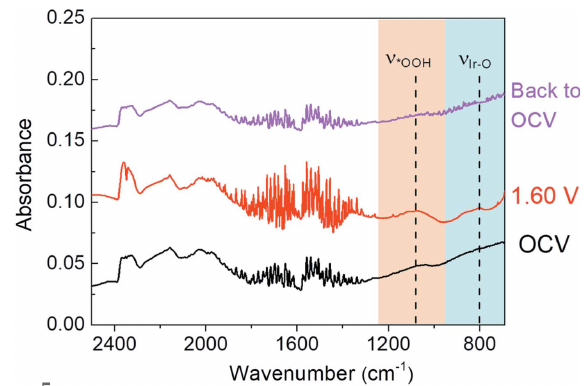
Figure 5 FTIR spectra of the commercial IrO 2 catalysts under typical potentials. A constant y -axis offset method is employed to clearly present the change of the FTIR spectra, with offset values of 0, 0.06 and 0.12 for plots under OCV, 1.60 V and back to OCV,